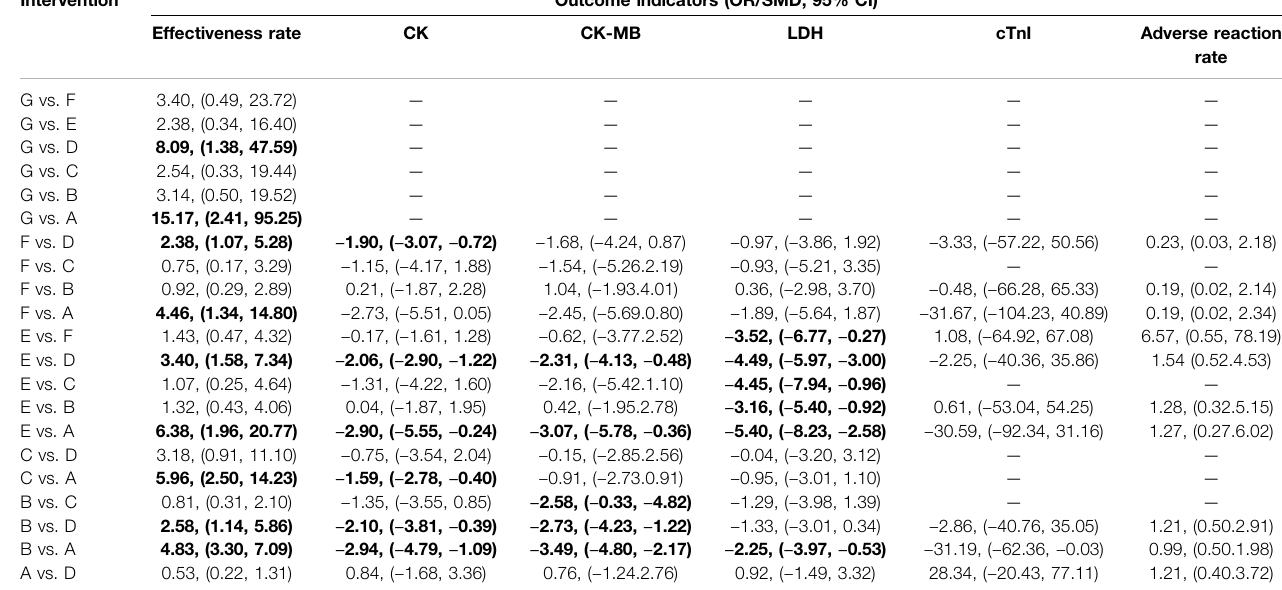
TABLE 2 | The network meta-analysis results of the outcome indicators. Intervention Outcome indicators (OR/SMD, 95% CI) Effectiveness